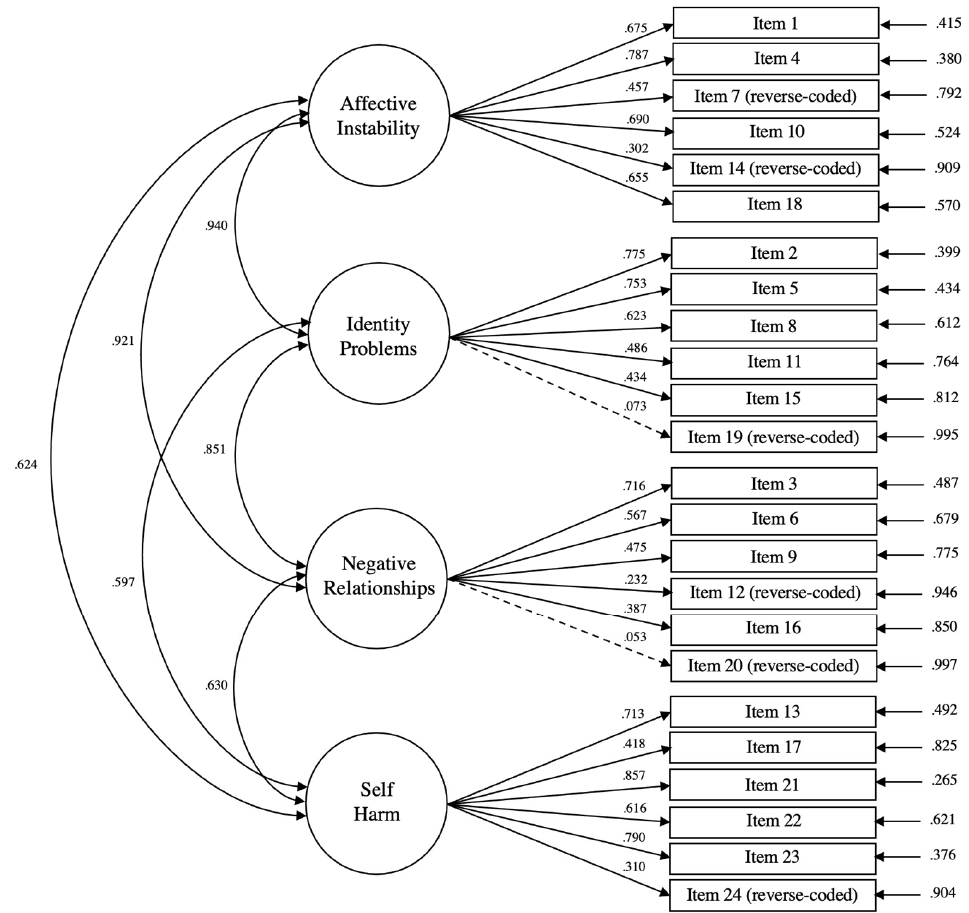
Figure 1. Confirmatory factor analysis of four ‐ factor measurement model of BPD symptomatology . Circles represent latent variables while boxes represent manifest variables (tasks). Single ‐ headed arrows connecting latent variables to manifest variables represent standardised factor loadings. Double ‐ headed arrows connecting latent variables represent latent intercorrelations. Single ‐ headed arrows on the right of the figure represent error terms. Solid lines represent significant relationships, while dashed lines represent non ‐ significant relationships, at the .05 level.